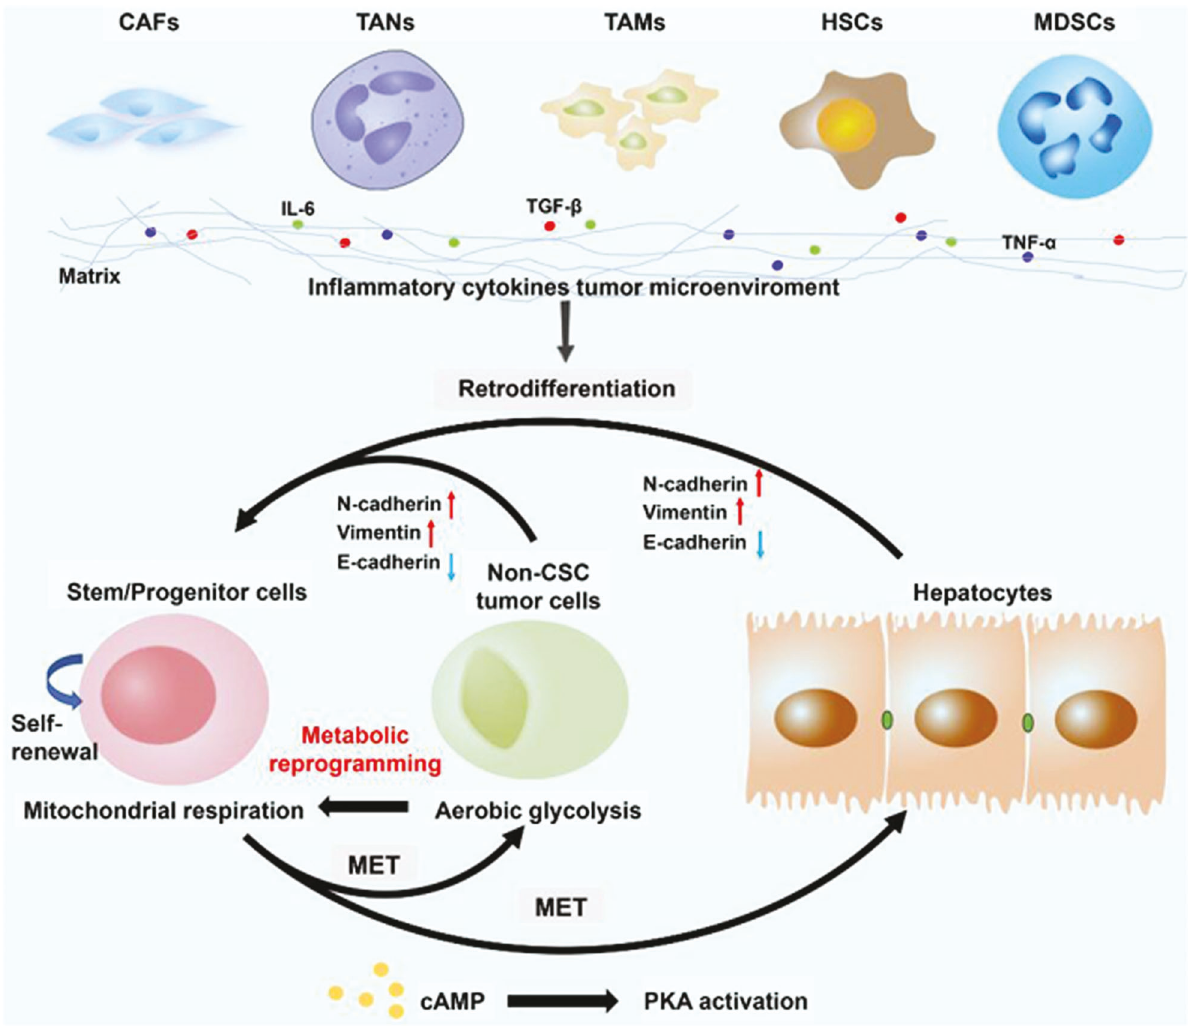
Fig. 4 The in fl ammatory cytokine tumor microenvironment promotes retrodifferentiation and cancer stemness maintenance in liver cancers. The process of retrodifferentiation includes EMT and metabolic reprogramming of non-CSC cells. Additionally, activation of PKA can induce MET in CSCs and lead to the loss of tumor-initiating ability in CSCs. CSCs cancer stem cells, EMT epithelial – mesenchymal transition, MET mesenchymal-to-epithelial transition, CAFs cancer-associated fi broblasts, TANs tumor-associated neutrophils, TAMs tumor-associated macrophages, HSCs hepatic stellate cells, MDSCs myeloid-derived suppressor cells, PKA protein kinase